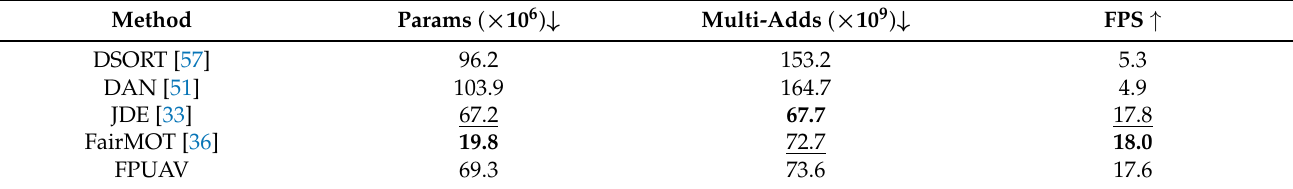
Table 3. Comparison with state-of-the-art methods on